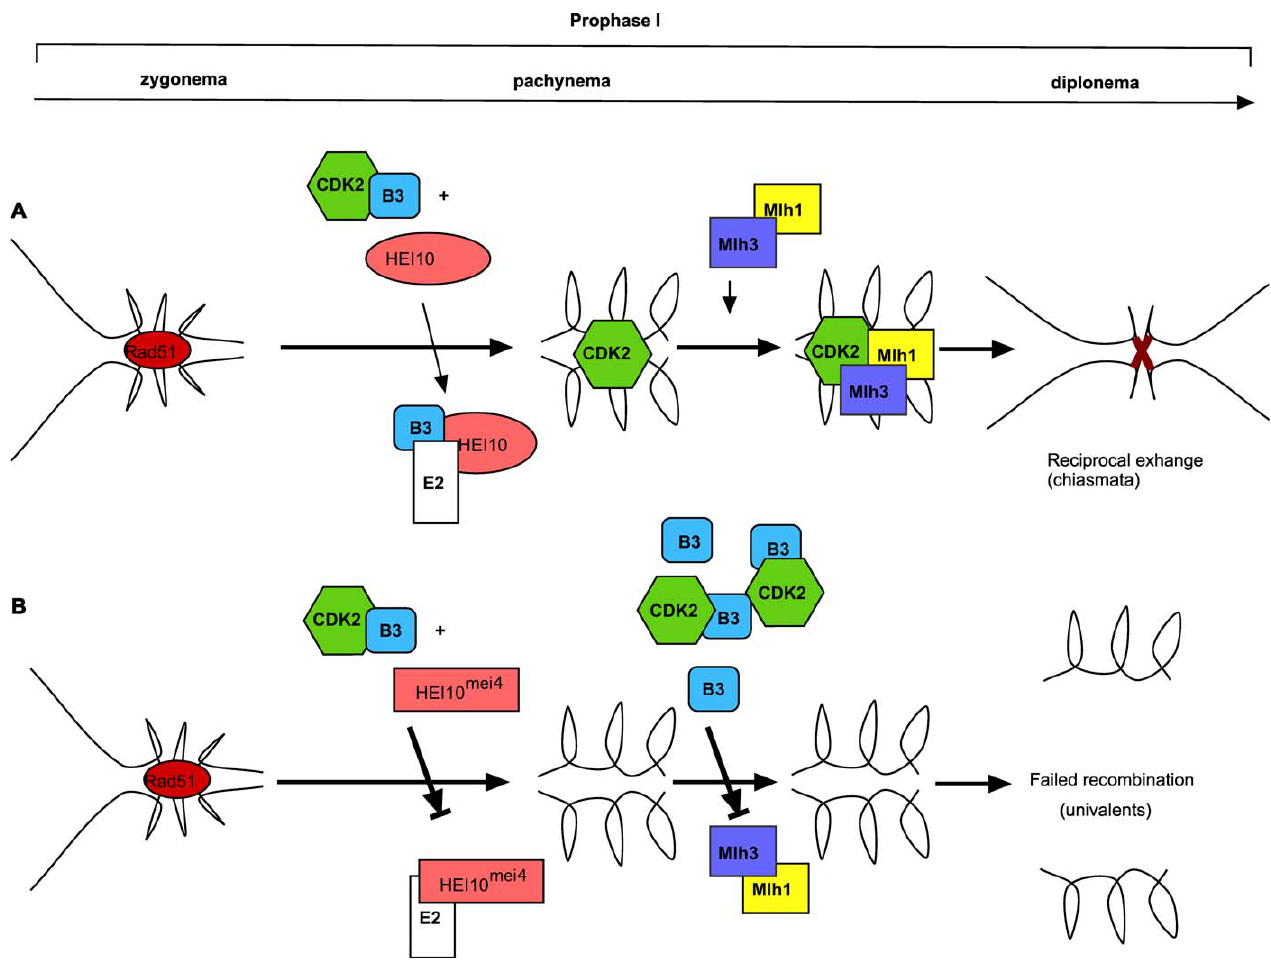
Figure 8. Proposed Mechanism: HEI10 mei4 Mediated Failure to Degrade CCNB3 Leads to Inability to Recruit MLH3 and MLH1 Resulting in Failed